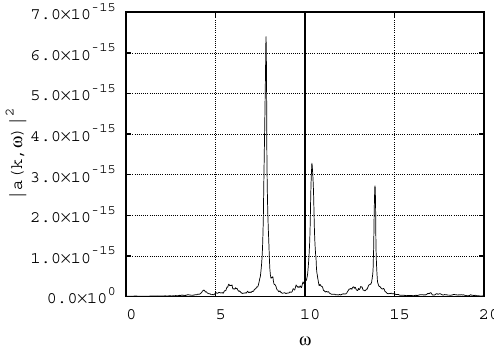
Figure 20. Spectral line of the harmonic k = (0, 200). The conden- sate was present.